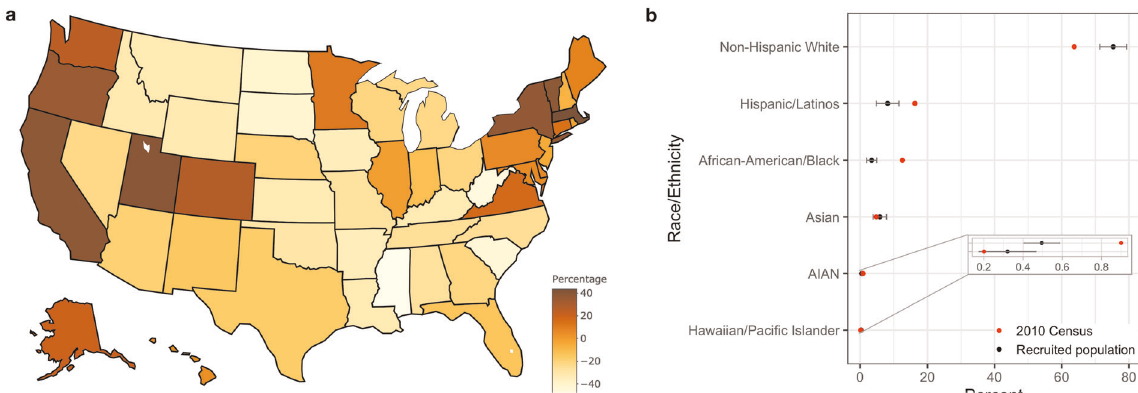
Fig. 1 Geographical and race/ethnic diversity of the recruited participants. a Map of US showing the proportion (median across the studies) of recruited participants relative to state ’ s population proportion of the US and b Race/Ethnicity proportion of recruited participants compared to 2010 census data. The median value across the studies is shown by the black point with error bars indicating the interquartile